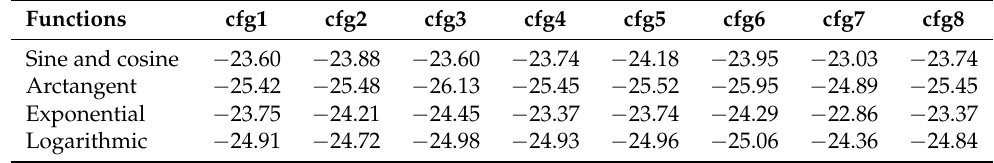
Table 2. The normalized value of the maximum absolute error of functions under different configurations.